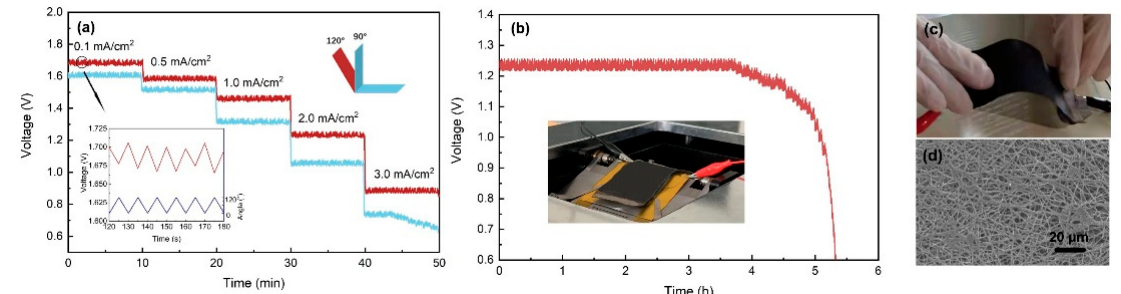
Figure 7. ( a ) Rate discharge profiles at dynamic bending state. ( b ) Galvanostatic discharge curve at